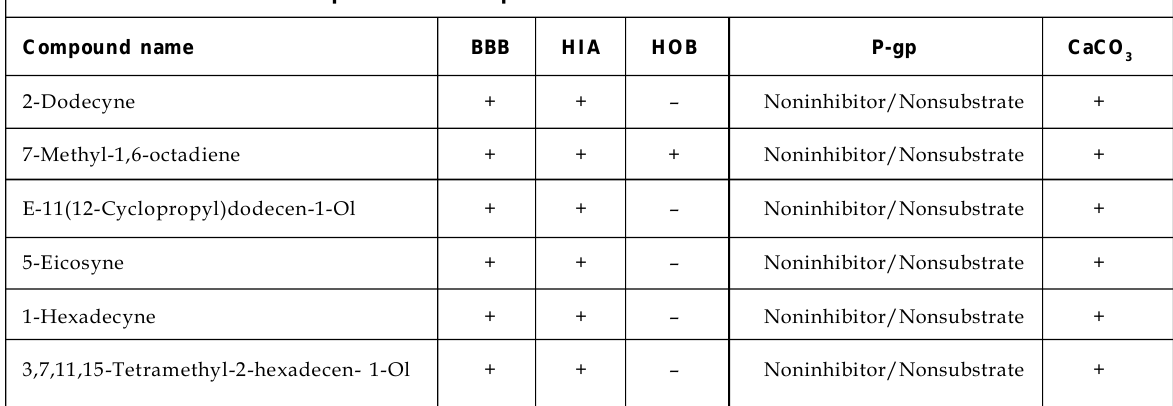
Table 2: Assessments of absorption of the